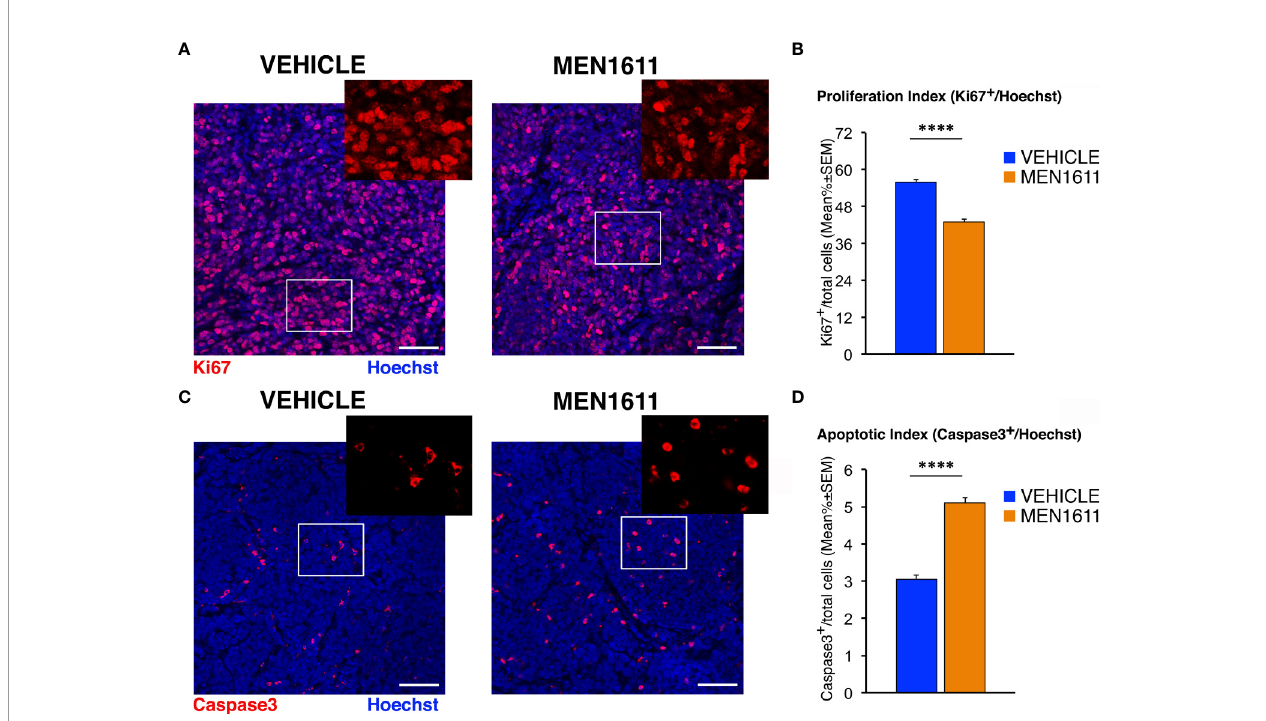
FIGURE 7 | MEN1611 inhibits cell proliferation and increases apoptosis in the Ptch1 +/ − /Tis21 KO secondary tumors. (A) Representative confocal images of mitotic cells, identi fi ed as Ki67 + cells (in red), in the nodules of Ptch1 +/ − /Tis21 KO MB allograft treated with MEN1611 or vehicle. Sections were stained with Hoechst 33258 to visualize the nuclei. Scale bar, 50 m m. White boxes, areas at higher digital magni fi cation (2×). (B) Quanti fi cation of cells positive for the proliferation marker Ki67 in the secondary tumors of mice treated with MEN1611 or vehicle, measured as mean ± SEM percentage ratio between the number of Ki67 + cells and the total number of cells (labeled by Hoechst 33258; proliferation index). **** p < 0.0001, Student ’ s t test. Mice analyzed: n = 6 for each treatment; total fi elds analyzed: n = 264 for each treatment. (C) Representative confocal images of nodules from MEN1611 and control groups, stained for the apoptotic marker cleaved Caspase-3 (red) and for the nuclei dye Hoechst (blue). Scale bar, 50 m m. At the top right of each tumor image, the digital enlargement (2×) of the white box area is shown. (D) Quantitative analysis of tumor cells expressing activated Caspase-3 in the nodules of MEN1611-treated and vehicle-treated mice. Data are mean ± SEM percentage ratio between the number of Caspase-3 + cells and the total number of cells, labeled by Hoechst 33258 (apoptotic index). **** p < 0.0001, Mann-Whitney U -test. Mice analyzed: n = 6 for each treatment; total fi elds analyzed: n = 287 for vehicle and n = 322 for